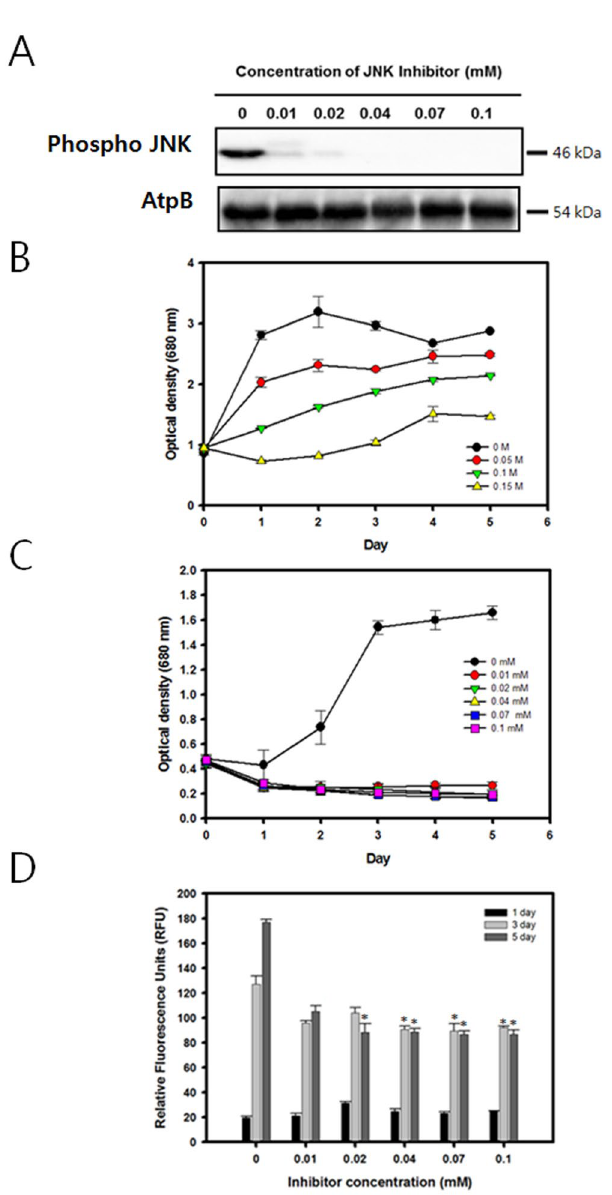
Figure 5. The expression level of JNK and cell growth profile and lipid accumulation of C . reinhardtii grown in media containing 0.1 M NaCl with various concentrations of the JNK inhibitor SP600125. ( A ) Western blot analysis against anti-JNK. Full-length blots are presented in Supplementary Fig. S6. ( B ) Cell growth (O.D. 680 nm) without SP600125 ( C ) Cell growth (O.D. 680 nm) with various concentrations of SP600125. ( D ) Nile red fluorescence measurement at 3 and 5 days after osmotic stress induction. Data are represented as mean ± SD ( n = 3). Significant differences were determined by Student’s t-test and indicated by asterisks ( * P < 0.05, ** P < 0.01, *** P <